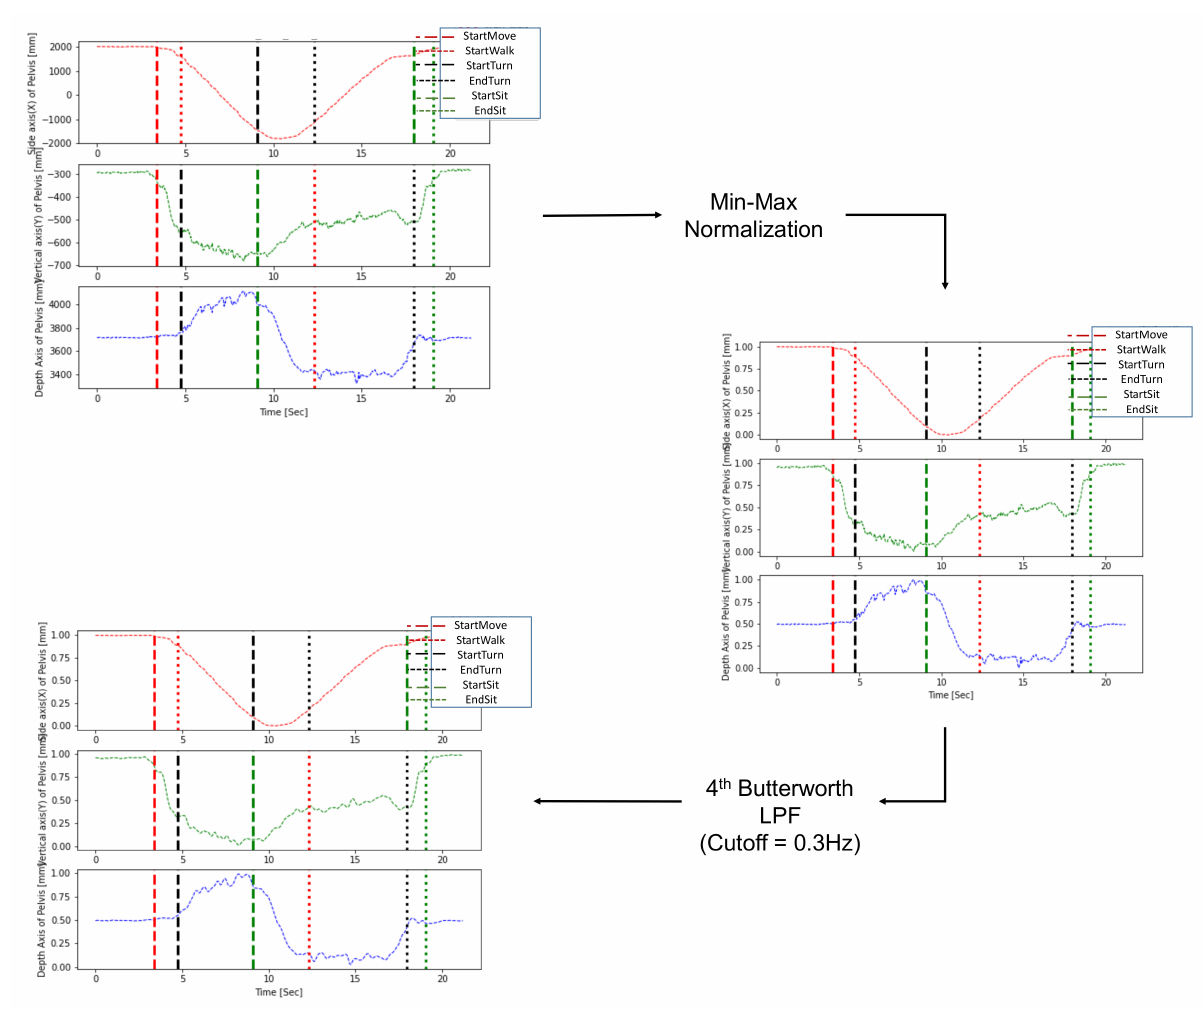
Figure 3. Preprocessing by low pass filter and normalization for a pelvis